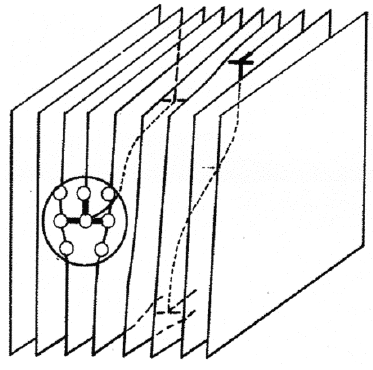
Figure 1. Schematic dislocation picture.